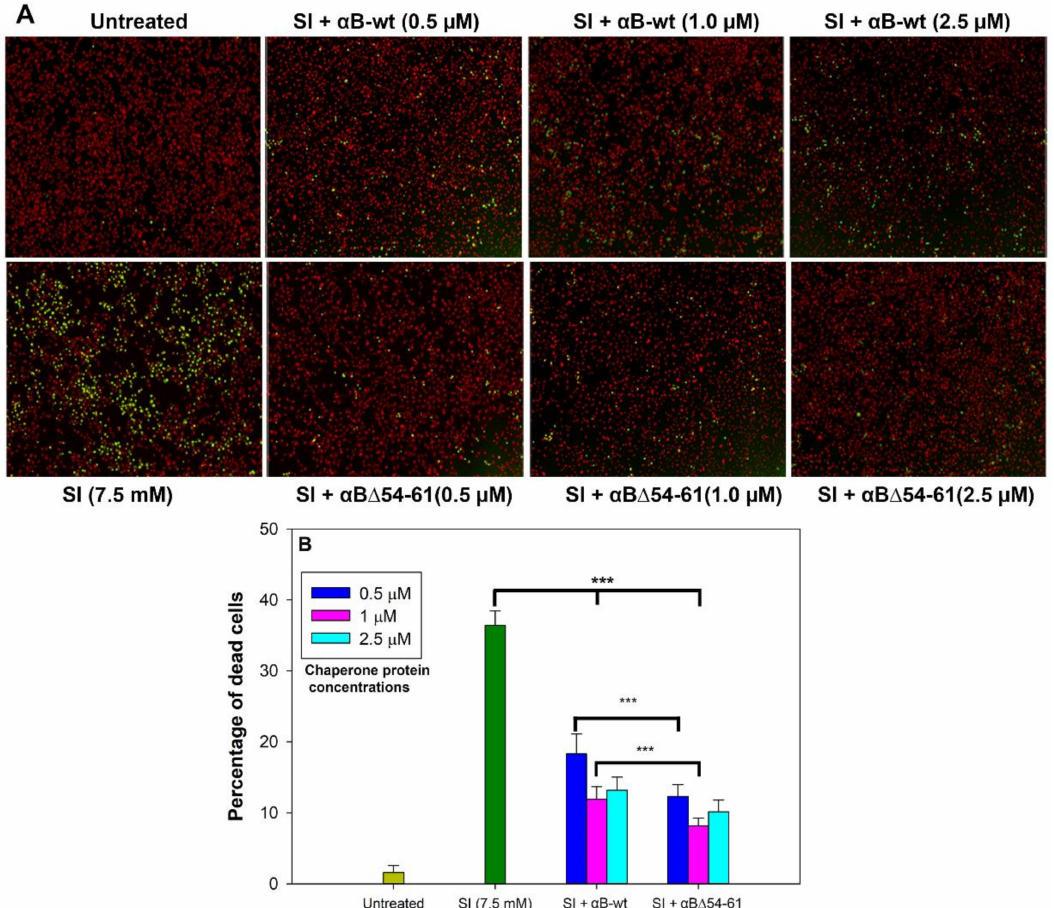
Figure 6. Anti-apoptotic activity of α B-wt and α B ∆ 54–61 against SI-induced apoptosis in ARPE-19 cells. ( A ) Serum-starved ARPE-19 cells were simultaneously treated with 0.5–2.5 µ M proteins and 7.5 mM sodium iodate for 24 h as described under Methods. Cytotoxicity was measured using an EarlyTox cell integrity assay kit from Molecular Devices, San Jose, CA, USA as described under Methods. The cells were imaged on a SpectraMax MiniMax 300 Imaging Cytometer (Molecular Devices) equipped with a single 4X objective. ( B ) Bar diagram showing the percentage of dead cells calculated after live/dead cell imaging using SoftMax Pro software (Molecular Devices). The data shown are an average of six analyses performed on images captured from different wells. The asterisks (***) indicate a p -value < 0.005 ( n =